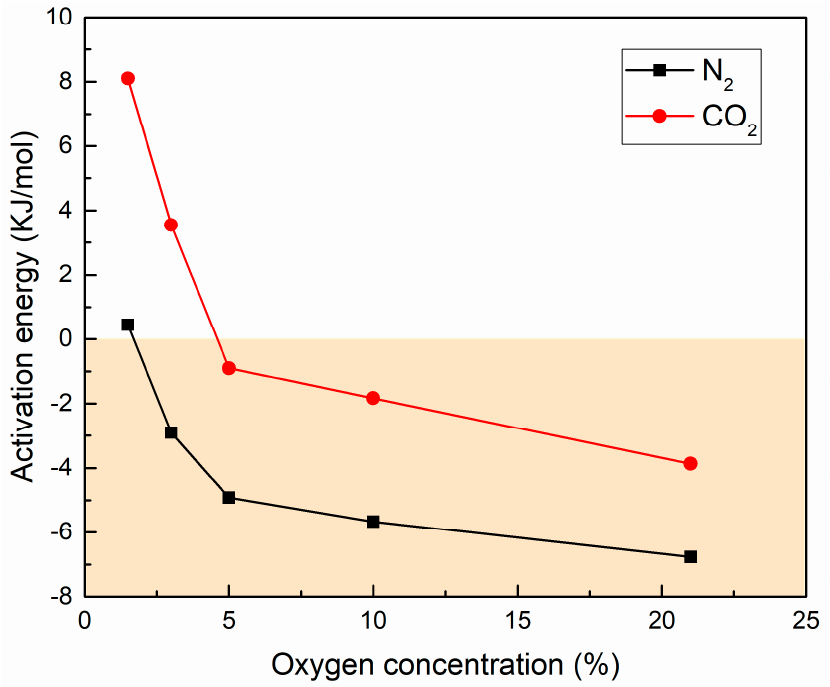
Figure 4. Activation energy of coal oxidation in the N 2 and CO 2 atmospheres.